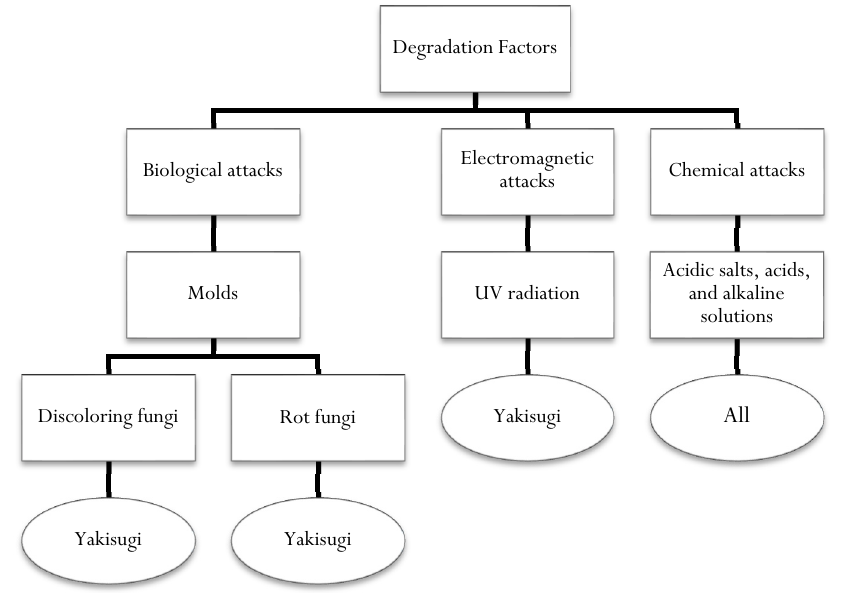
Figure 2. Overview of surface treatments demonstrating best characteristics regarding degradation factors arising from outdoor exposure.